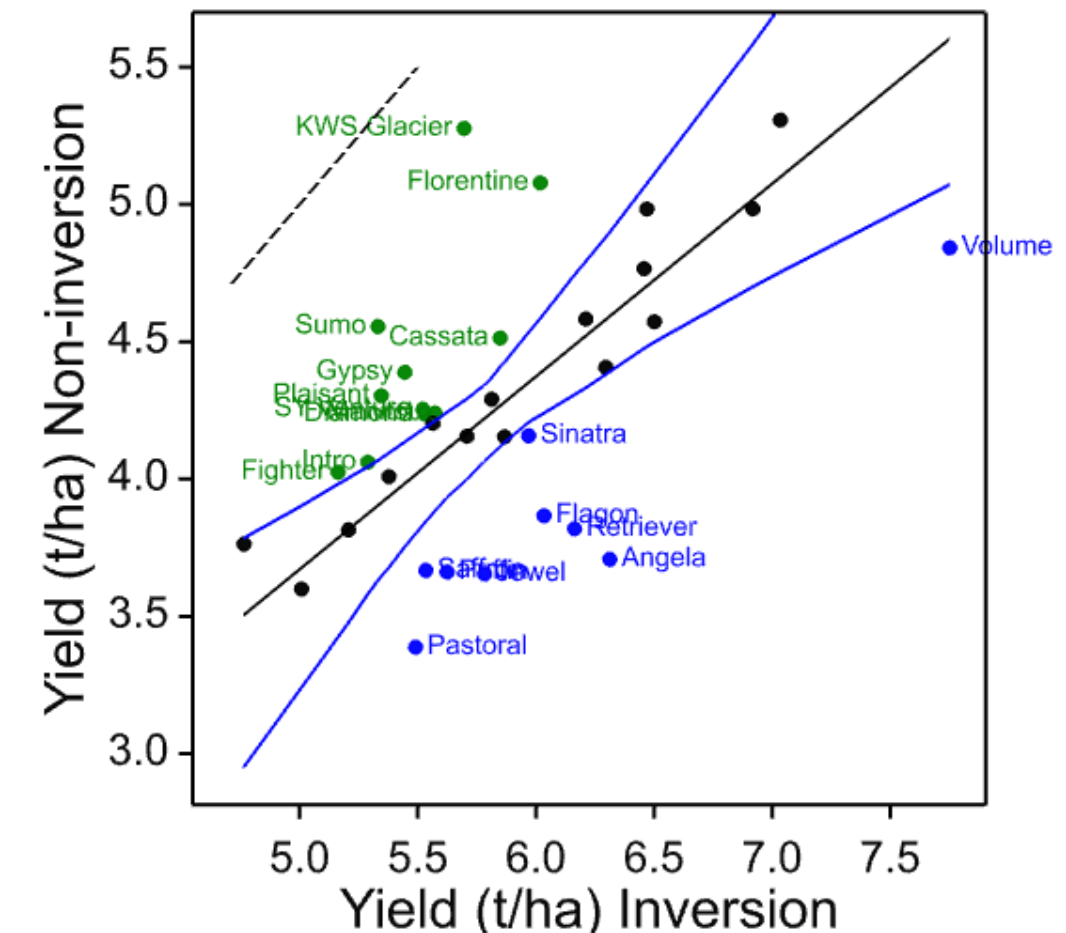
Figure 11. Regression of non-inversion yield on inversion yield for 35 winter barley cultivars in the 2012 trial. The blue lines show the 95% confidence interval of the regression line (solid black), while the dashed line shows the 1:1 yield ratio. Only cultivars outside the confidence limits are labelled for clarity, blue below and green above. Table 13. Absolute yield rank differences for the 2012 trial. Number of cultivars shows the number of cultivars with the given rank change and Cumulative shows the number with that rank change or greater. The 50%, 90% and 95% points are from the simulated variables and show the distribu- tion of the number of cultivars that exhibited an absolute rank change at least as large as that speci fi ed due to random variation, as described in the text.